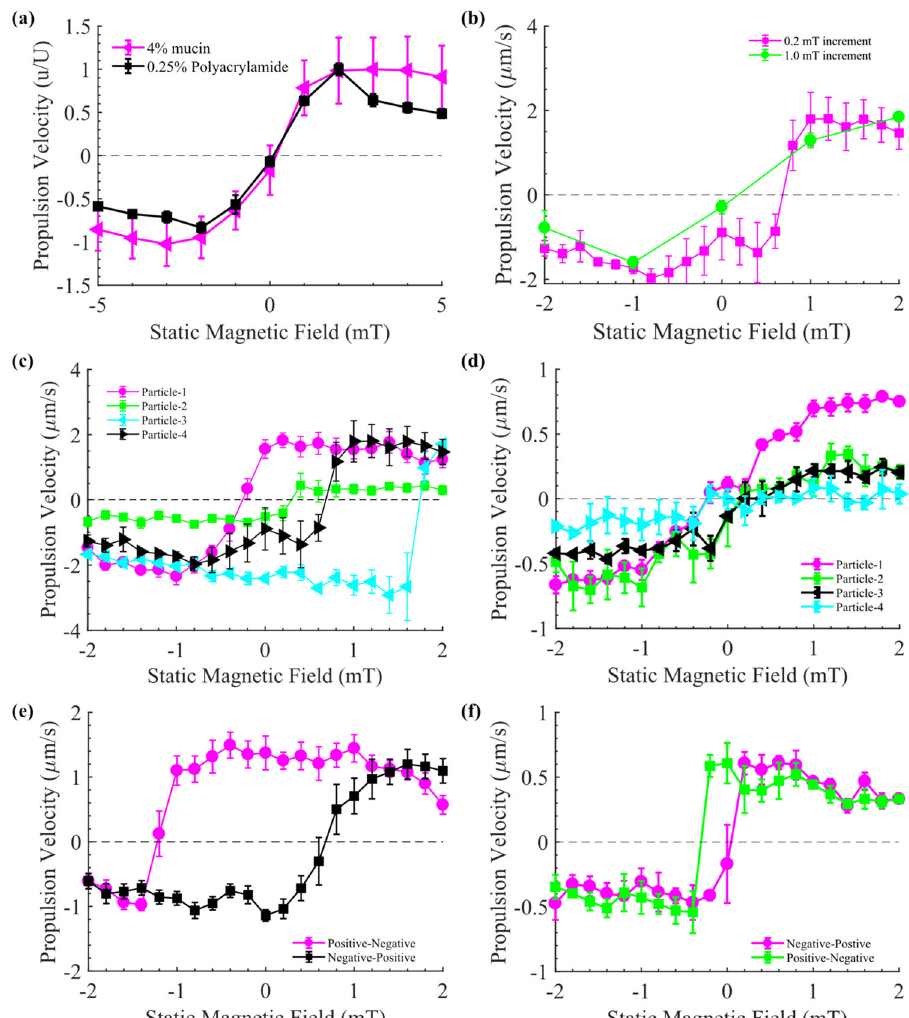
Fig. 3 Effect of static magnetic fi eld on propulsion. Velocity vs. static magnetic fi eld for 10 μ m diameter microparticles for: a static fi eld swept at 1 mT increments between the range of − 5 to 5 mT, with the microparticles rotated at 15 Hz. Four microparticles were examined and each had at least three trials in each fl uid. b Static magnetic fi eld swept at 0.2 and 1 mT increments for the same microparticle in 4% mucin. c , d Static magnetic fi eld swept at 0.2 mT increments for 4 different particles for 4% mucin and 0.25% polyacrylamide, respectively. e , f Propulsion hysteresis in response to static magnetic fi eld sweep at 0.2 mT increments for a single microparticle in 4% mucin and 0.25% polyacrylamide, respectively. The frequency for ( f ) was 40 Hz with the (cid:1) (cid:1) (cid:1) (cid:1) ¼ 0 : 1750 f , where f is the frequency in Hz. In all scenarios, velocities of microparticles remained relatively rotating magnetic fi eld amplitude set to B r constant at larger positive and negative fi elds, but the fi eld at which velocity switched direction depended on static magnetic fi eld history, increment size, and speci fi c particle characteristics. Dashed lines in graphs represent zero propulsion velocity while lines between points in ( a – f ) were added to act as a guide to the eyes. Statistics: ( a ) Four particles were examined in 4% mucin and six particles in 0.25% polyacrylamide; each microparticle had at least three independent trials. ( b ) Five trials were conducted at 1 mT and four trials at 0.2 mT. ( c ) Six, four, fi ve, and four trials were conducted for particles 1 – 4, respectively. ( d ) Four trials were conducted for each particle examined. ( e ) Ten independent trials were conducted for a single microparticle. ( f ) Four independent trials were conducted for a single particle. Data are presented as mean±standard error. Source data are provided as a source data fi